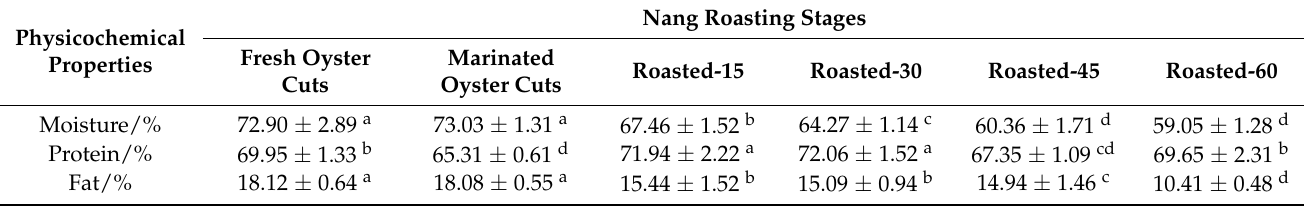
Table 1. Changes of physicochemical properties in lamb oyster cuts during Nang roasting (dry matter basis).